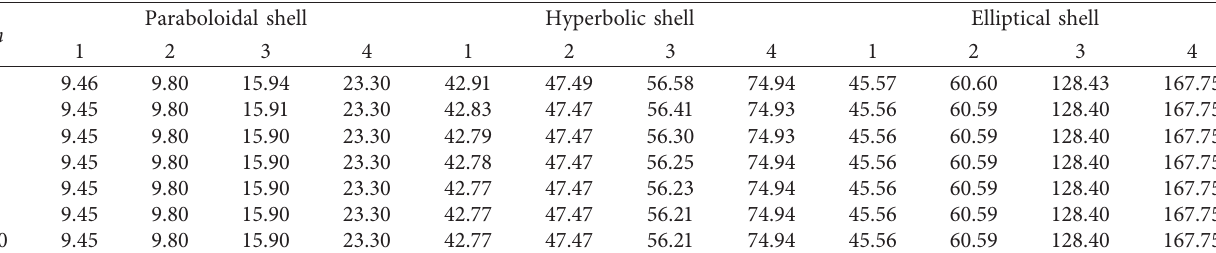
Table 2: Convergence analysis of truncation terms for Sandwich FGP doubly curved structure. Paraboloidal m